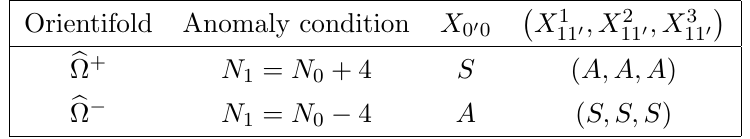
Table 4. The orientifold involutions b (cid:10) of dP 1 with gauge groups U( N 0 ) (cid:2) U( N 1 ). \A" stands for \Antisymmetric representation", while \S" for \Symmetric